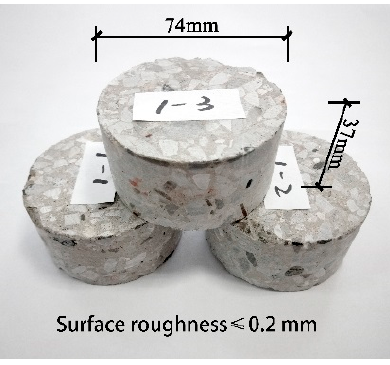
Figure 3. Three identical SHPB specimens of each condition.